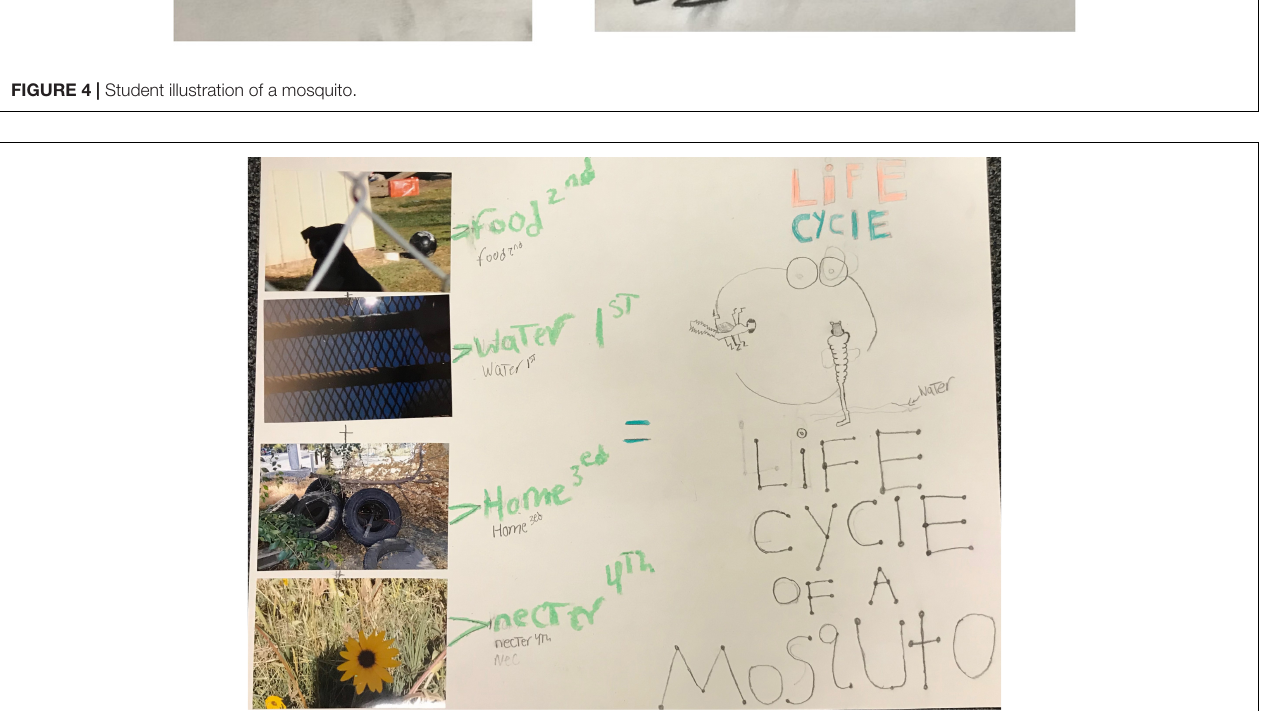
FIGURE 5 | Student collage of the mosquito